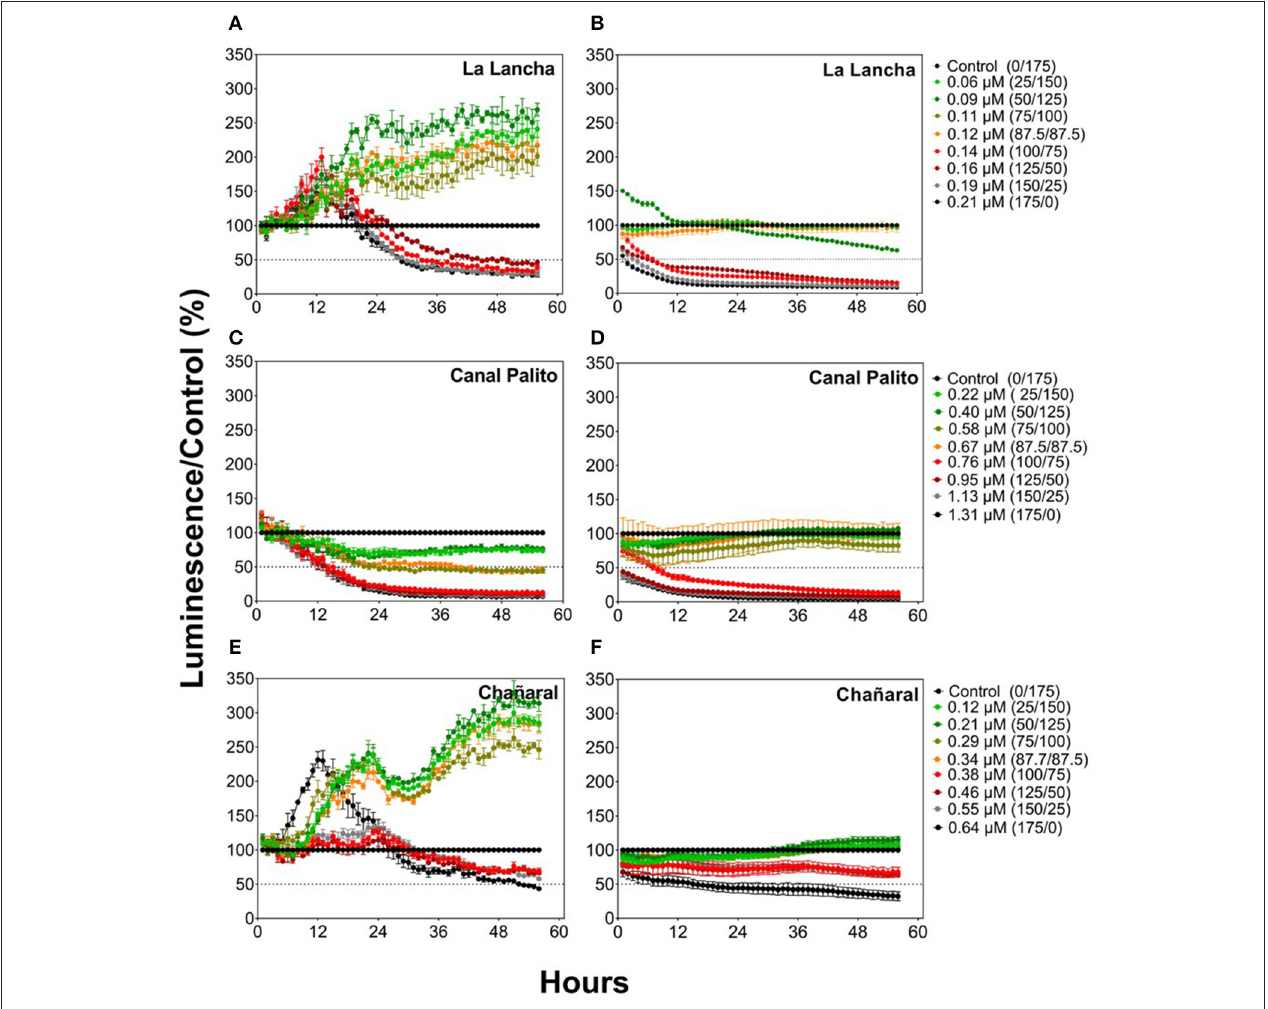
FIGURE 3 | Responses of the O. tauri Fer-RI-Luc (A,C,E) and CDKA-Luc (B,D,F) reporter luminescent lines after exposure to seawater with different Cu concentrations. Graphs represent normalized data compared to the control lines (0.04 µ M of Cu). Theoretical Cu concentrations were estimated based on initial concentrations in polluted sweater and on dilutions in reference seawater, as displayed in descriptions for the